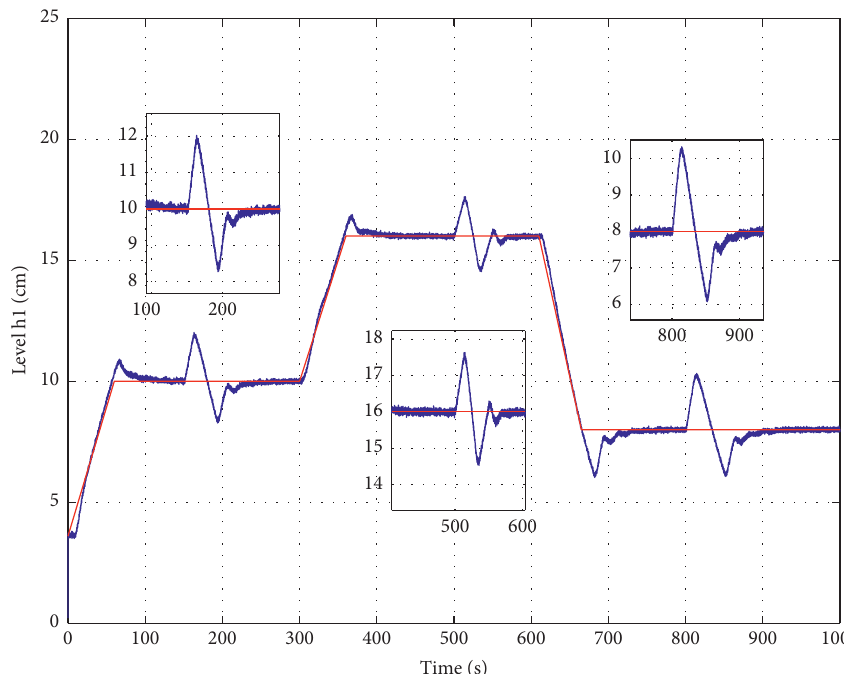
Figure 11: Experimental result for IBC tracking and its impact on external disturbance.